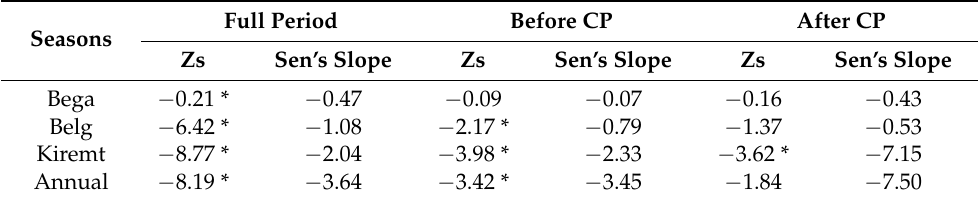
Table 7. The M–K test and Sen’s slope results of seasonal and annual mean streamflow before the changing point (1986–2007), after the changing point (2008–2015), and full study period (1986–2015). Full Period Before CP After CP Seasons Zs Sen’s Slope Zs Sen’s Slope Zs Sen’s Slope Bega − 0.21 * − 0.47 − 0.09 − 0.07 − 0.16 − 0.43 Belg − 6.42 * − 1.08 − 2.17 * − 0.79 − 1.37 − 0.53 Kiremt − 8.77 * − 2.04 − 3.98 * − 2.33 − 3.62 * − 7.15 Annual − 8.19 * − 3.64 − 3.42 * − 3.45 − 1.84 −